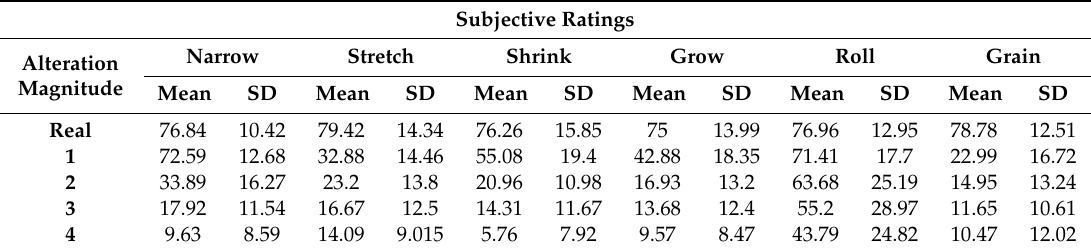
Figure 3. Subjective judgments of reality. ( A – F ) Changes in subjective reality a ff ected the ratings of Sense of Reality (SoR) in a relatively consistent manner. Reality ratings for unaltered environments were highest while ratings for altered environments were reduced, suggesting a consistent tuning curve for SoR. ( G ) Subjective ratings for all aspects showed high, positive, and significant correlations. ( H ) Example of the correlation between participants’ subjective rating of grow and shrink . ( I ) Significant di ff erence between the drop in subjective ratings for grow and shrink , indicating an asymmetrical response for inducing changes in the first person perspective (1PP). Table 2. Descriptive statistics for experiment